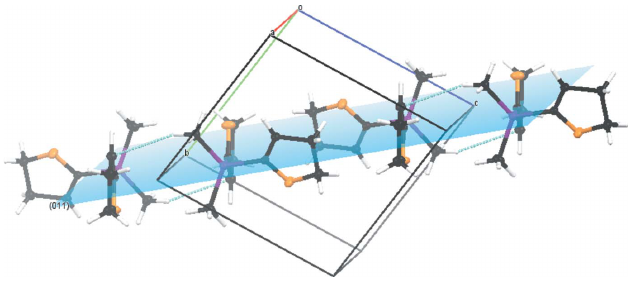
Figure 4 The crystal packing of compound 1 with the (011) plane shaded in blue. C—H (cid:4)(cid:4)(cid:4) C van der Waals interactions are shown as dashed lines. H10 A (cid:4) (cid:4) (cid:4) C2 i = 148.4 (8) (cid:2) ; symmetry code: (i) (cid:3) x + 1, (cid:3) y + 2,